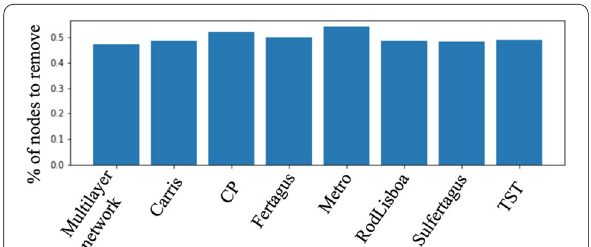
Fig. 13 Minimum percentage of nodes that need to be removed to separate the network into only isolated components, using targeted extractions. The lower this value, the less resilient this network